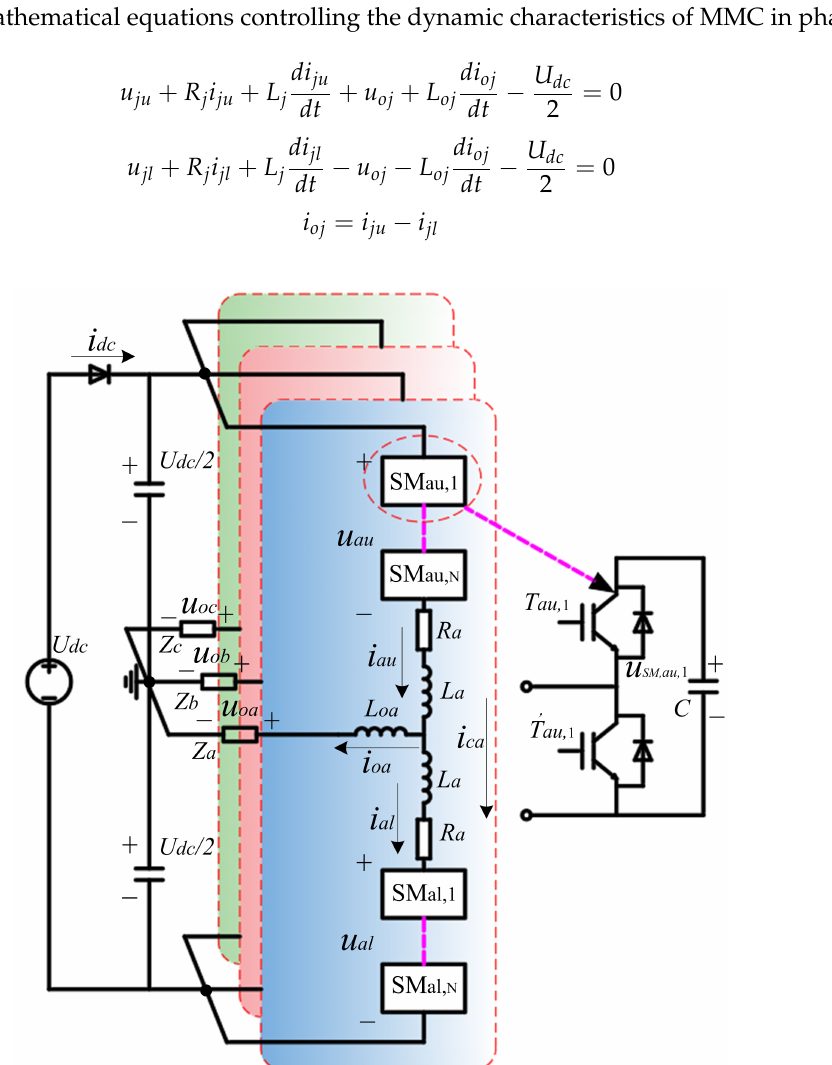
Figure 1. Structure of a three-phase MMC-based inverter and its